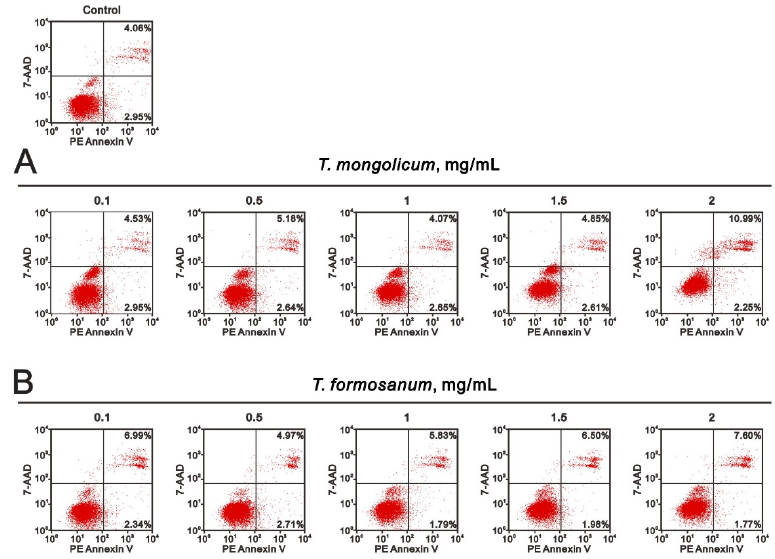
Figure 6. Effects of T. mongolicum and T. formosanum on apoptosis in MDA-MB-231 cells. MDA-MB-231 cells were treated for 24 h with the indicated concentrations of ( A ) T. mongolicum or ( B ) T. formosanum . They were then subjected to Annexin V apoptosis analysis. Early apoptotic cells are PE Annexin V ‐ positive and 7 ‐ AAD ‐ negative, while late apoptotic cells are both PE Annexin V ‐ positive and 7 ‐ AAD ‐ positive.